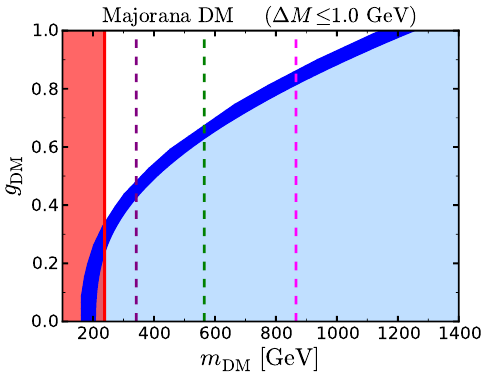
Figure 7 . Model 1a: plot of the coupling g versus the dark matter mass m DM = m (cid:31) . We scan DM over (cid:1) M 1 GeV, where (cid:1) M = M (cid:30) m (cid:31) , this is the mass region where the HSCP limits are (cid:20) (cid:0) independent of the coupling g . The dark blue band satis(cid:12)es the correct DM relic abundance DM within 3 (cid:27) , the region in light blue overproduces the amount of DM. The colour-coding for the exclusion regions is the same as in the previous